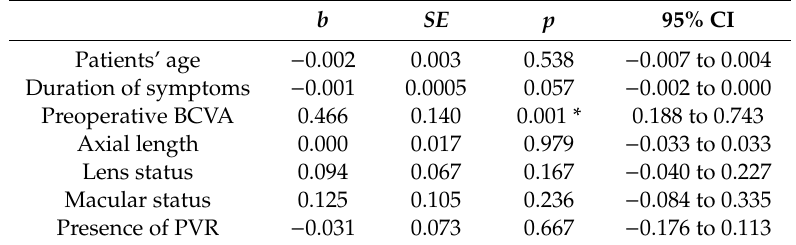
Table 5. The e ff ect of preoperative factors related to patient and ocular clinical findings on postoperative BCVA. b SE p 95% CI Patients’ age − 0.002 0.003 0.538 − 0.007 to 0.004 Duration of symptoms − 0.001 0.0005 0.057 − 0.002 to 0.000 Preoperative BCVA 0.466 0.140 0.188 to 0.743 Axial length 0.000 0.017